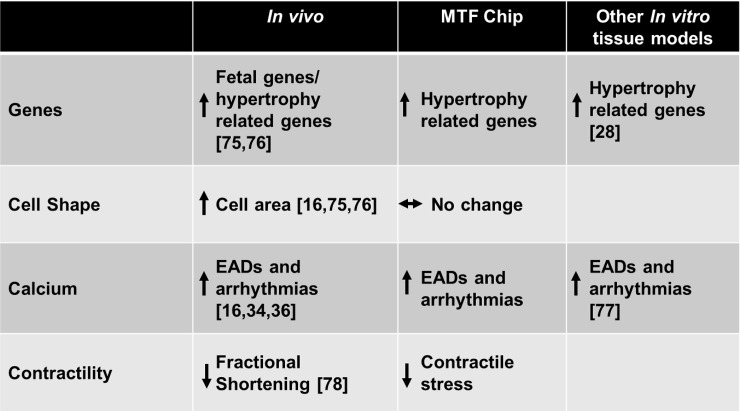
MTF chip performance assessment.Results from this study were used to compare the MTF chip based model to in vivo/ex vivo and other in vitro tissue model studies. Many models only examine certain features of pathology, this MTF chip based model mimics ventricular tissue architecture and generates multiscale readouts and can be used to compare healthy and diseased tissues.